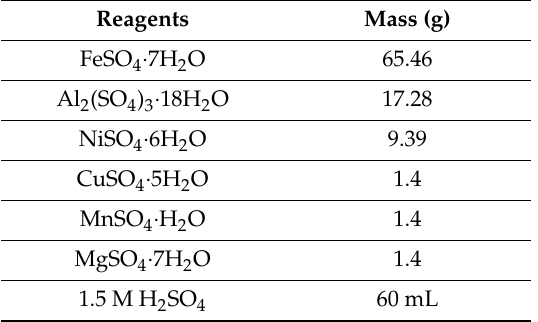
Table 1. Reagents needed for synthetic acid mine drainage (AMD) preparation.